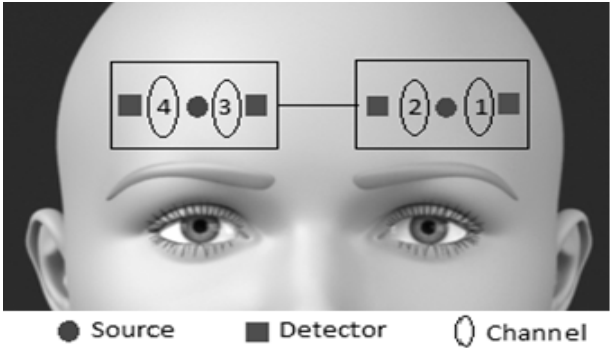
Figure 2. fNIRS sensor placement on the forehead with corresponding channel recording locations.